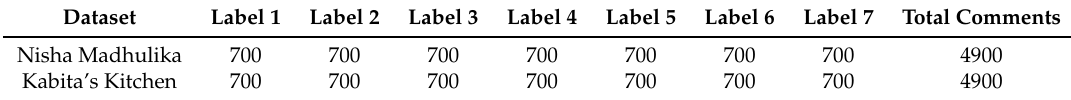
Table 3. Data comments